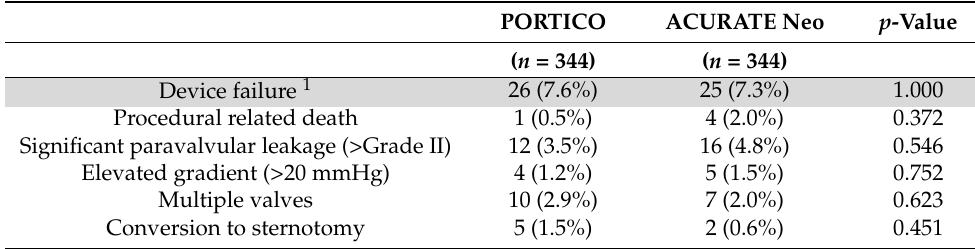
Table 3. Device failure for patients treated with PORTICO and ACURATE neo of the matched population.